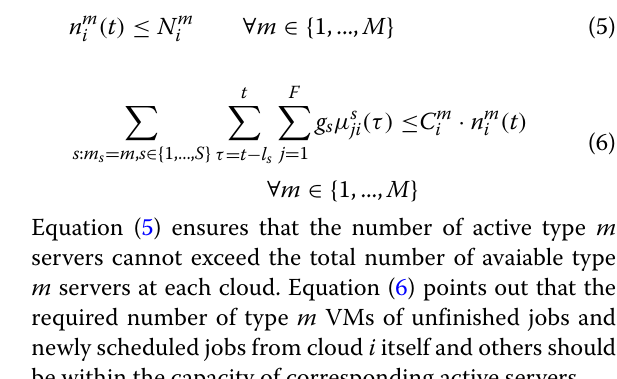
Q s will be 0 when the FIFO queue of type s job i